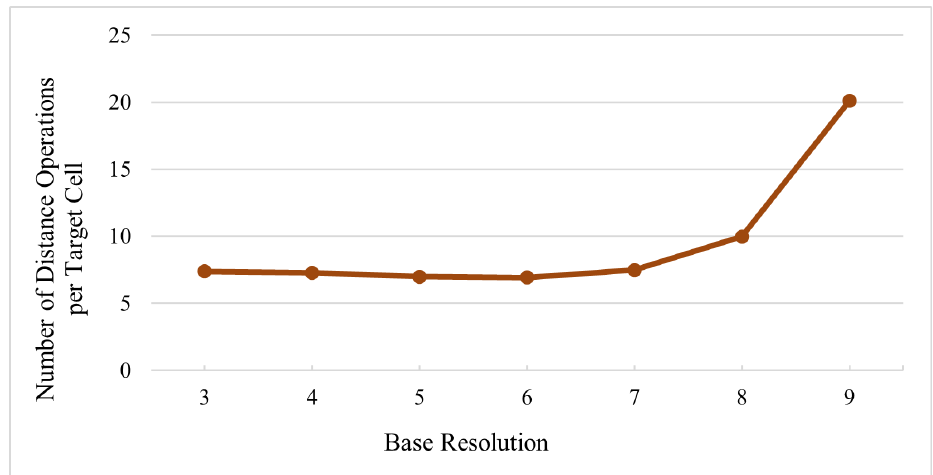
Figure 18. The effect of the base resolution on the performance of the iterative algorithm for the target resolution 12.